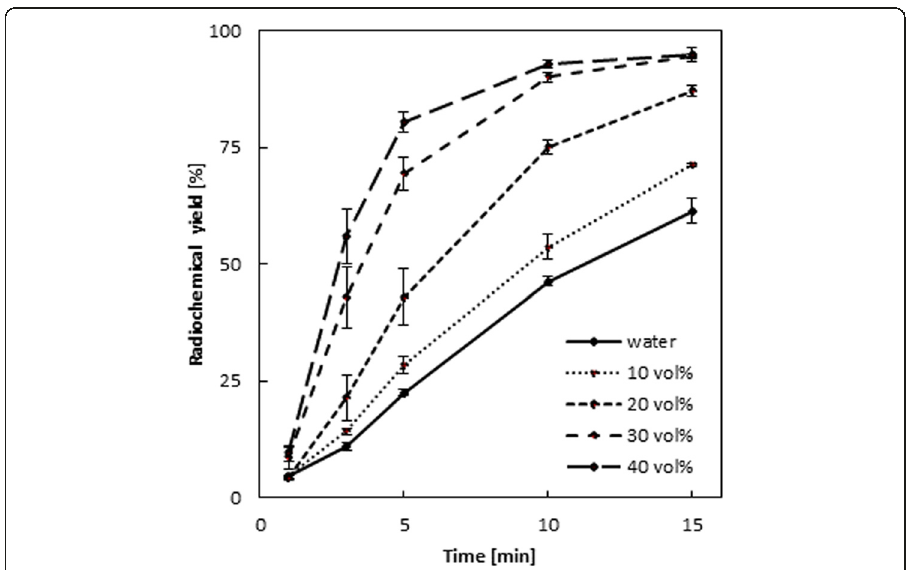
Fig. 2 Labeling kinetics of 68 Ga-DOTATOC in presence of 0 – 40 vol% ethanol (10 nmol/2.93 μ M/14.2 μ g DOTATOC, 70 °C, n =